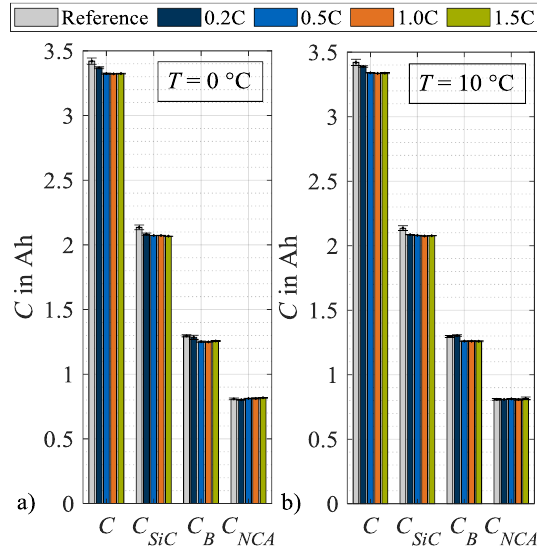
Figure 9. Absolute changes in characteristic capacities after load cycle 1 at ( a ) 0 °C and ( b ) 10 °C.